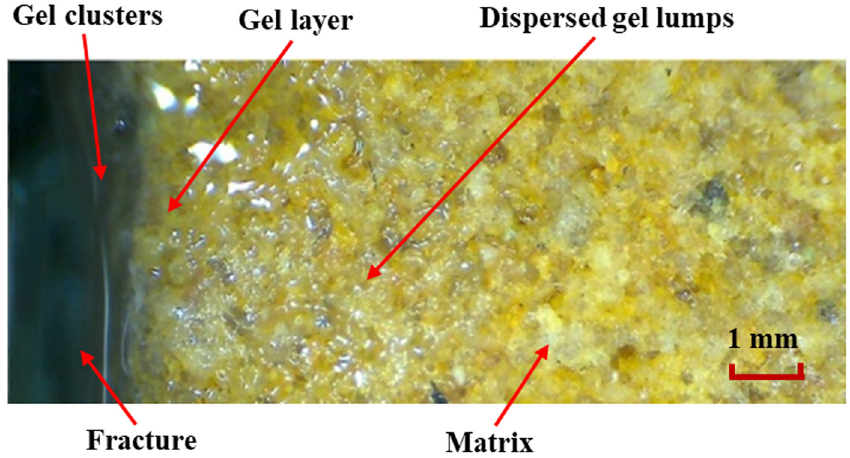
Figure 3: Overall distribution patterns of polymer gel in the fracture and matrix after gelling.